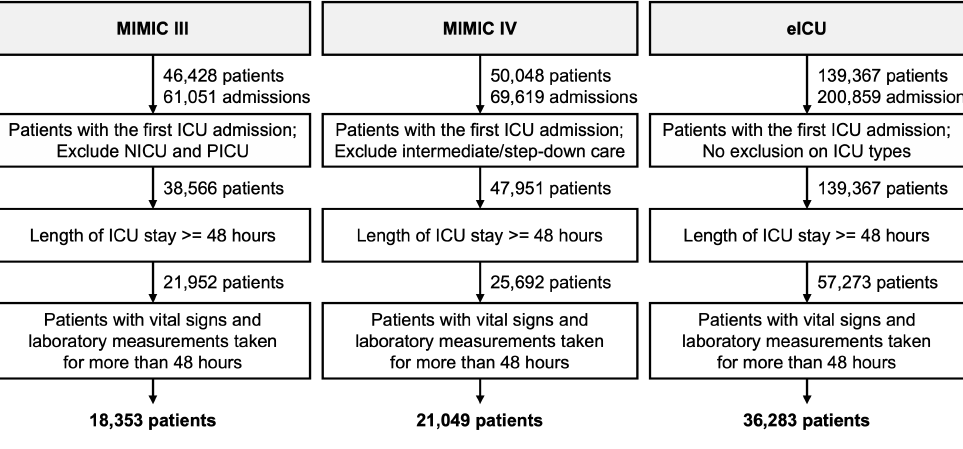
Figure 1. Flow chart for study cohort formation.